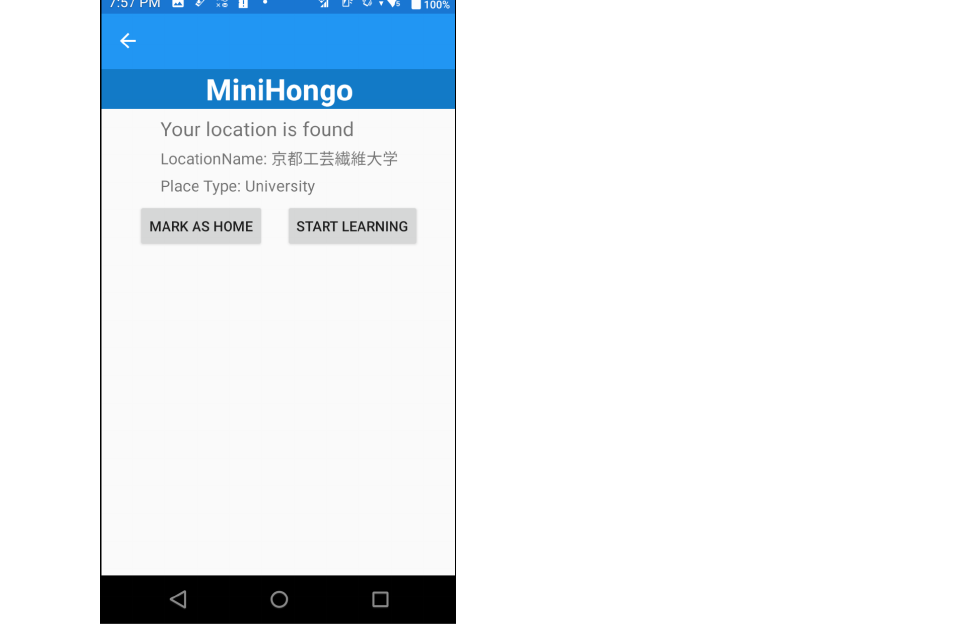
Figure 6. Location-detection page. The Japanese text displayed in the LocationName field refers to the name of the location, which translates to Kyoto Institute of